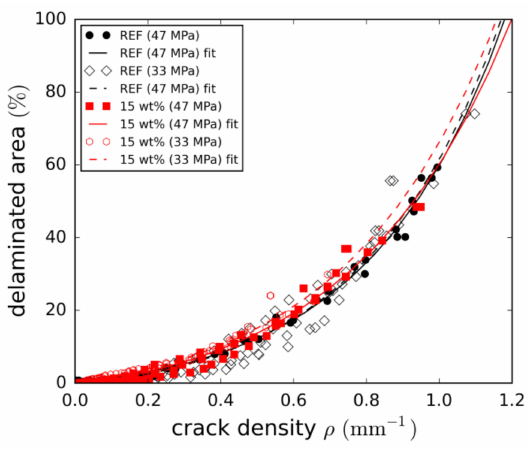
Figure 14. Correlation of crack density and